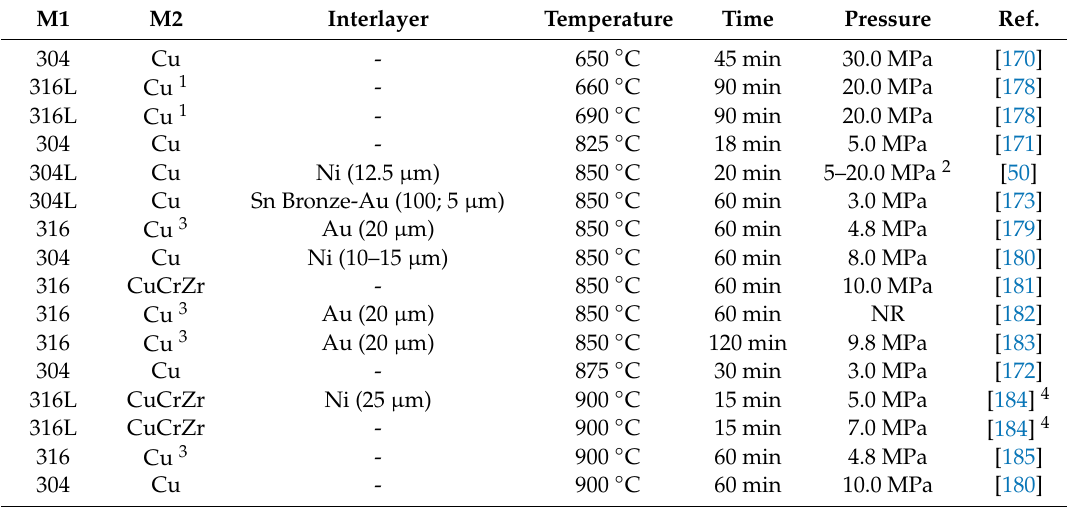
1 Oxygen-free high termal conductivity (OFHC) copper, 2 Impulse pressure di ff usion bonding (IPDB), 3 Dispersion strengthened (DS) copper, 4 done with Gleeble using current through